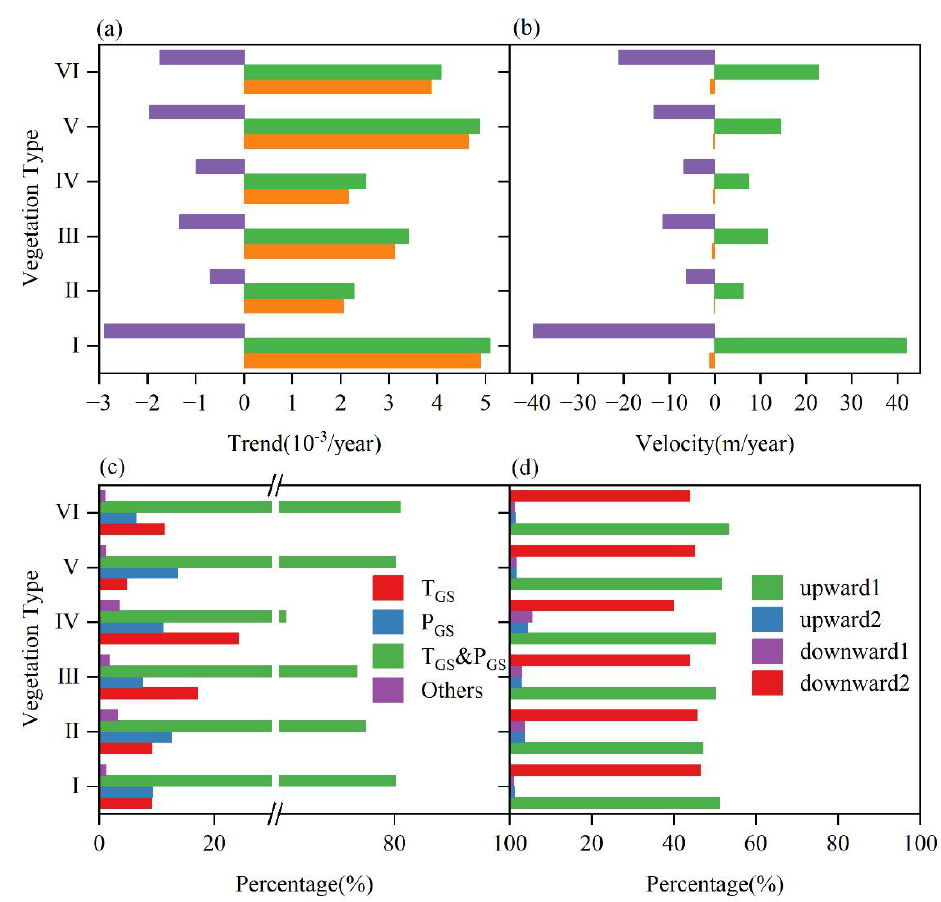
Figure 9. ( a ) Variation in the temporal trend of growing season NDVI (NDVI GS ) with vegetation type. ( b ) Vertical velocity of the vegetation greenness isolines for different categories of pixel (the orange bars indicate the mean values for all pixels, the green columns the mean values for all positive pixels, and the purple columns the mean values for all negative pixels). ( c ) The percentage of pixels corresponding to each of the four driving-factor cases and ( d ) the proportion of upward and downward pixels for each vegetation type. The codes used for the vegetation types are the same as those in Figure 1.